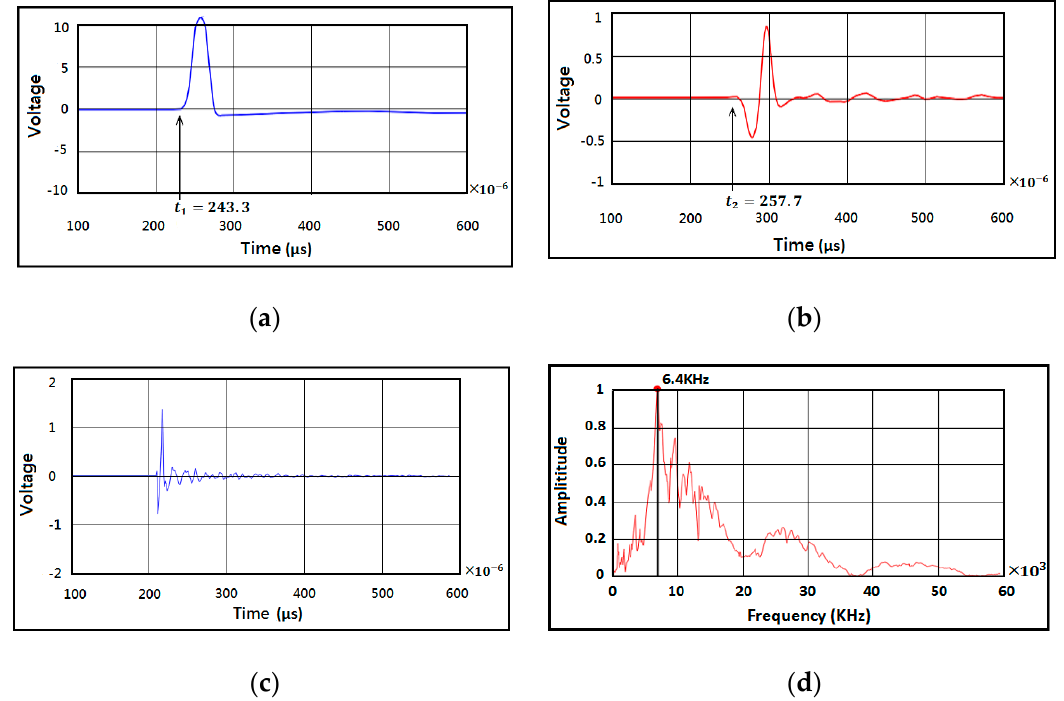
Figure 10. Regular concrete impact wave graph: ( a ) incident impact point wave graph; ( b ) first reflected wave waveform graph; ( c ) MATLAB simulation graph; ( d ) spectrogram.